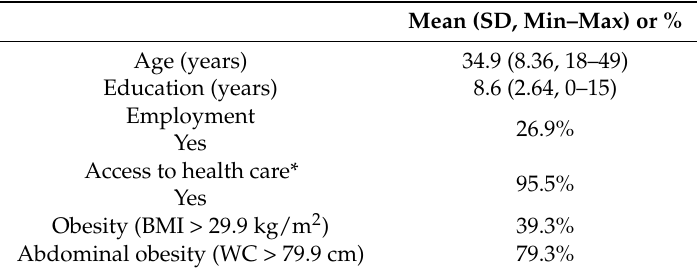
Table 2. Individual-level properties ( n = 67